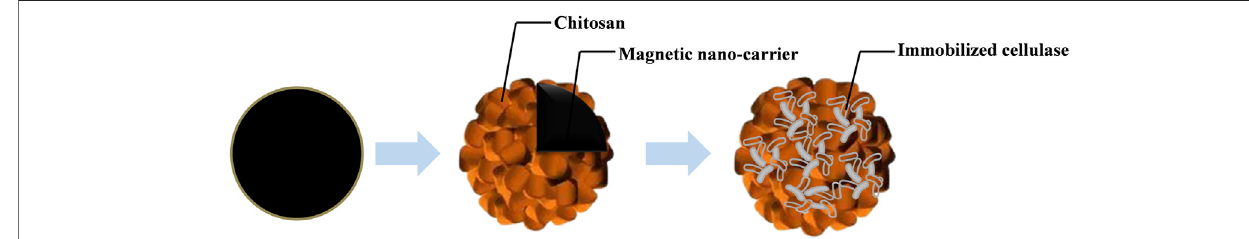
FIGURE 1 | Schematic diagram of immobilized cellulase on a magnetic nanocarrier.